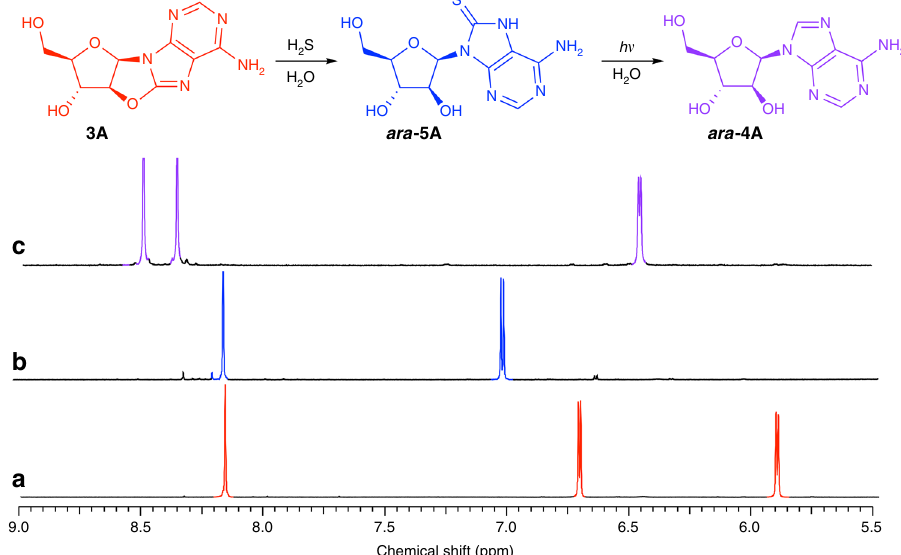
Fig. 2 Prebiotic synthesis of arabino -adenosine ( ara -4A ). 1 H NMR spectra (600 MHz, 9:1 H 2 O/D 2 O, 25 °C, δ = 5.5 – 9.0 ppm) showing: a anhydroadenosine ( 3A ; red). b Crude 8-mercapto- arabino -adenosine ( ara -5A ; blue) observed upon incubation of anhydroadenosine ( 3A ; 35.7 mM) and H 2 S (670 mM, 60 °C, 7 d, pH 7). c Crude arabino -adenosine ( ara -4A ; purple) after irradiation ( λ = 300 nm) of 8-mercapto- arabino -adenosine ( ara -5A ; 2 mM, room temperature,